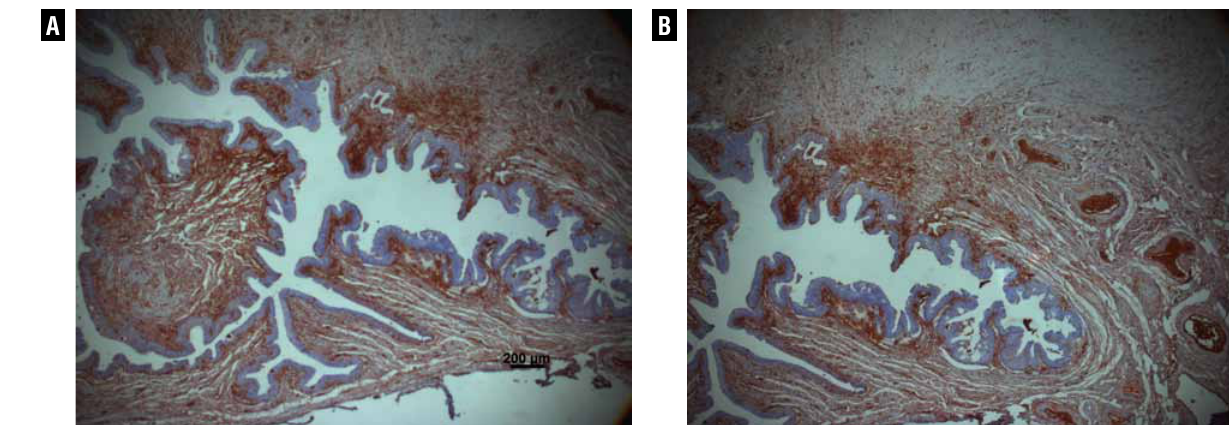
Figure 8 - A - Photomicrography of the urethra - Group I animal, postoperative day 90, immunohistochemistry with anti-Von Willebrand factor antibodies, 25x. B - Photomicrography of the urethra - Group II animal, postoperative day 90, immunohis- tochemistry with anti-Von Willebrand factor antibodies,